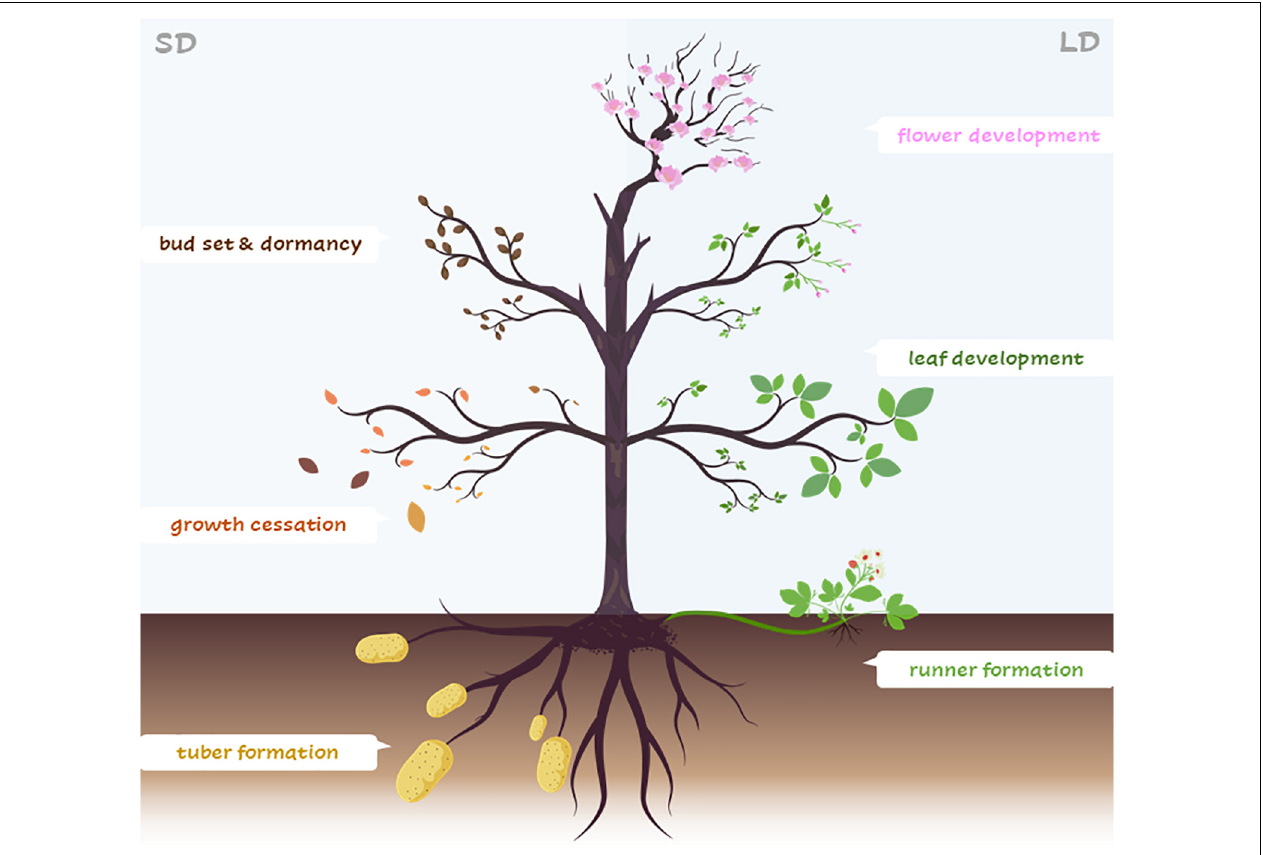
FIGURE 3 | Frankenstein plant. Representation of an imaginary plant showing specific developmental processes controlled by similar components of the photoperiodic pathway in different plant species. Under LDs (right) leaf and flower development, runner formation (specific for strawberry). Under SD (left) bud set/dormancy and growth cessation (perennial trees), tuber formation (specific for potato). TABLE 1 | Role of FT-like genes in photoperiod-controlled processes discussed in the review.